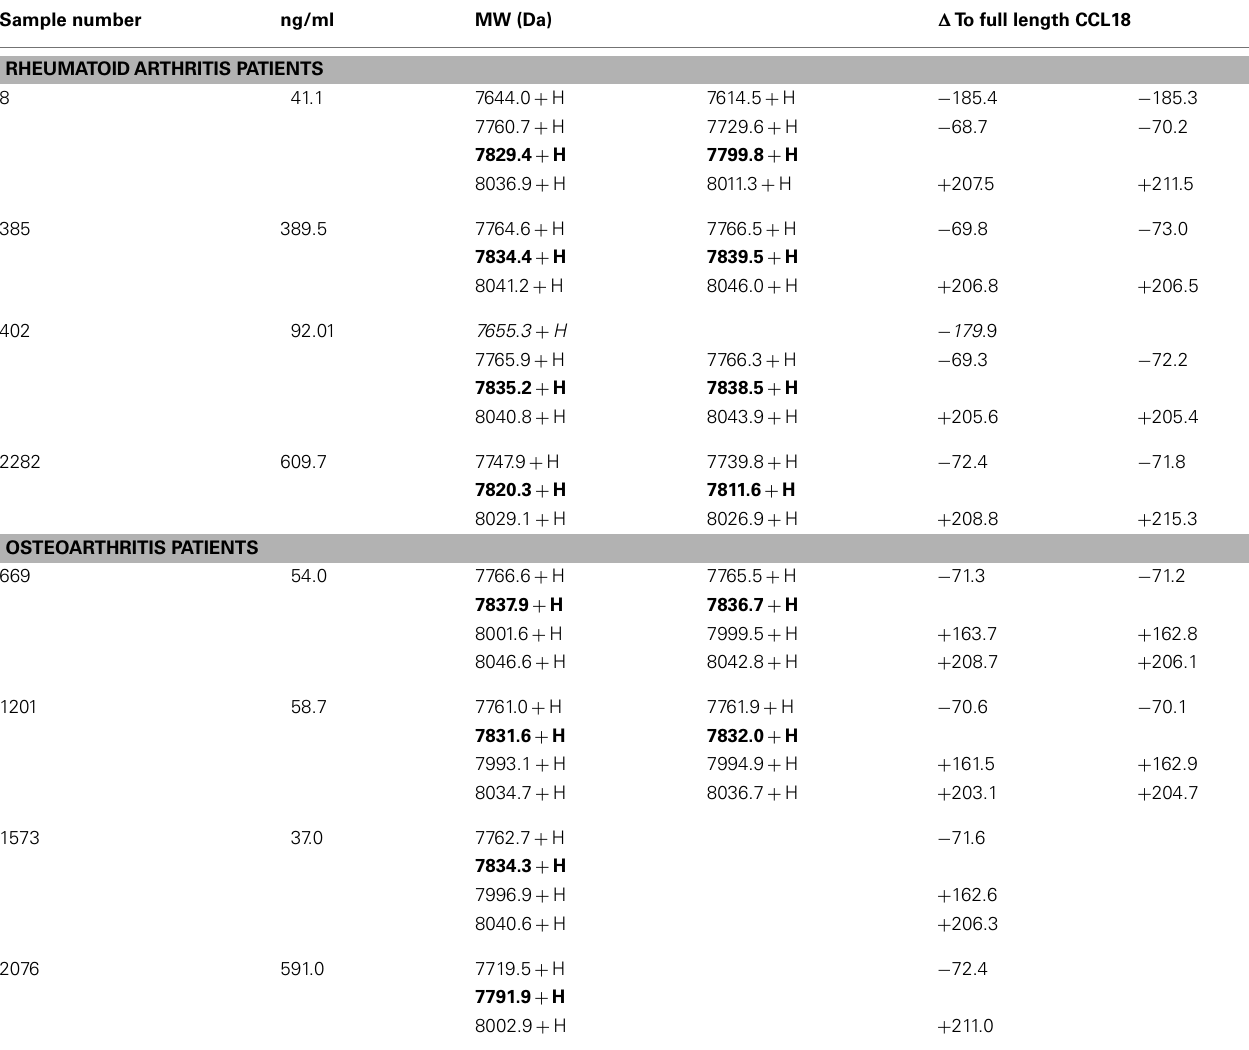
Table 1 | Summary of the mass detected in the synovial fluid samples of RA and OA patients by SELDI-TOF